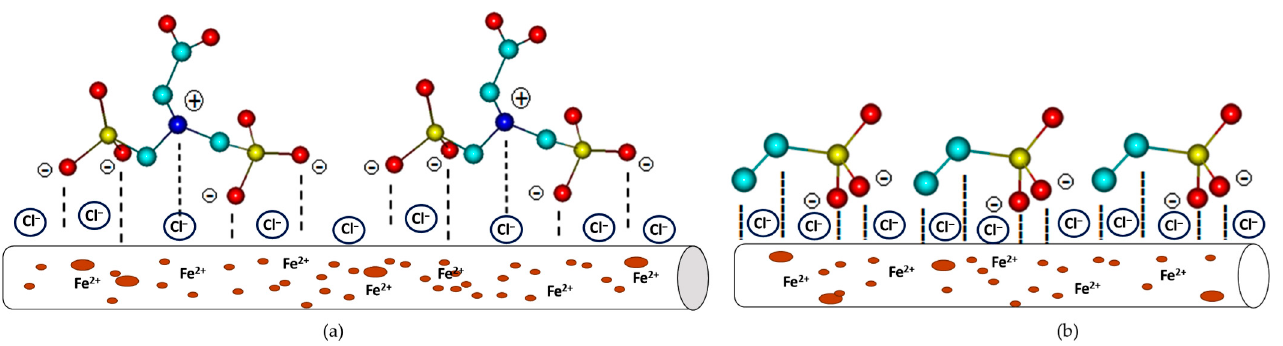
Figure 5. The possible mechanism of ( a ) PMG 3 − and ( b ) VPA 2 − corrosion protection studies. Color code: yellow—P, red—O, turquoise—C. The hydrogen atoms are omitted for clarity.